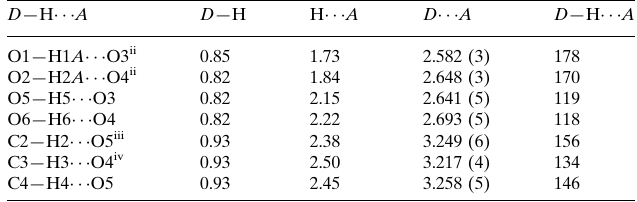
Hydrogen-bond geometry (A˚ , (cid:1)